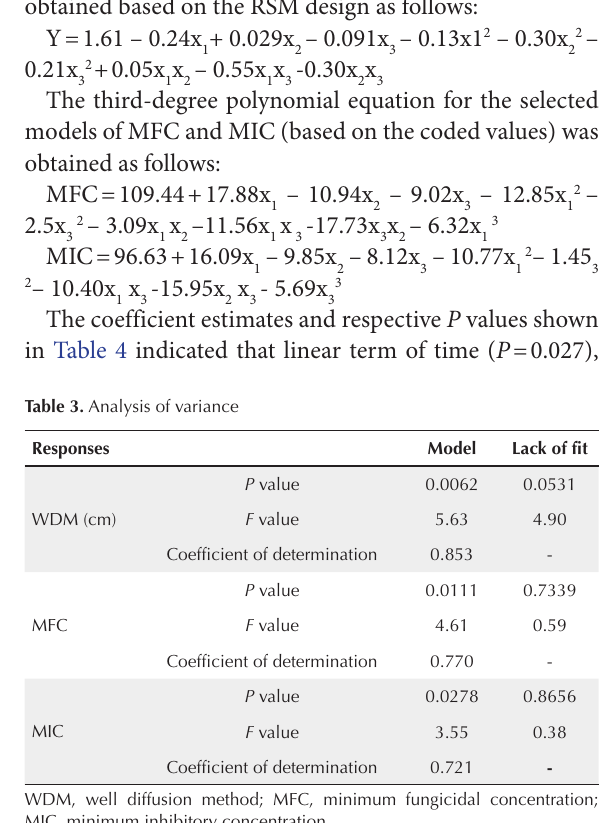
Table 4 . The estimated regression coefficients of the fitted equations for the WDM, MFC and MIC WDM Variable